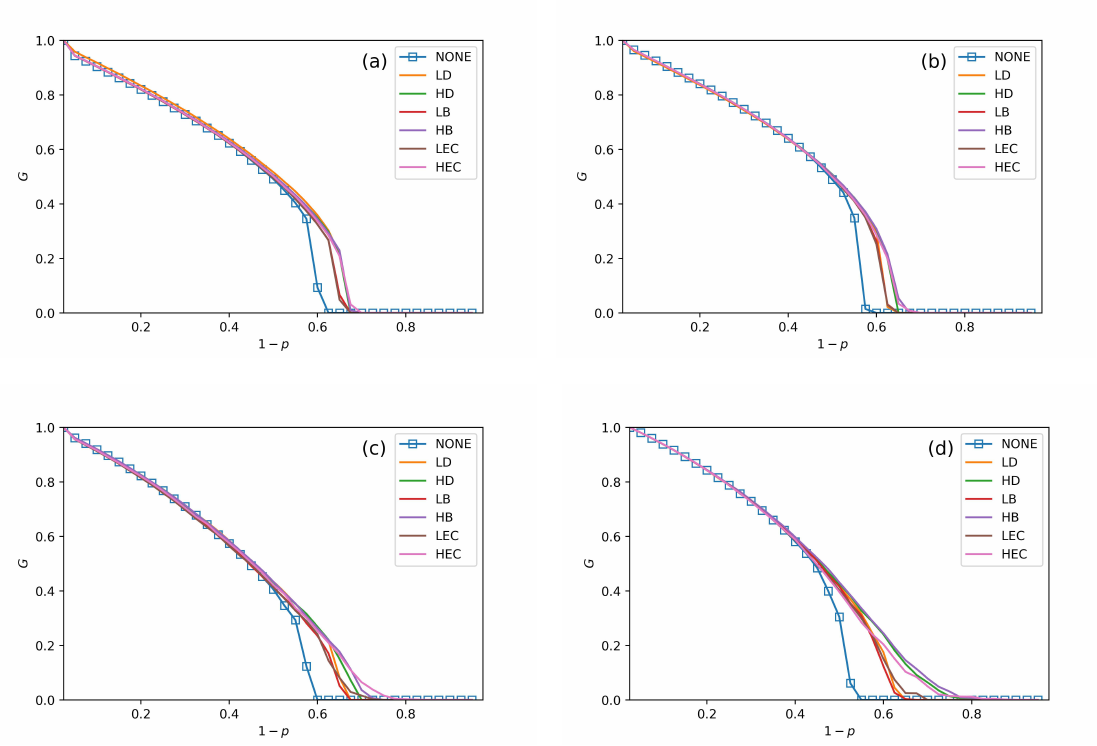
Figure 7. The fraction of function nodes in systems when f N = 70%. ( a – d ) are the systems that are being combined with ER–ER, ER–SF, SF–ER, and SF–SF,